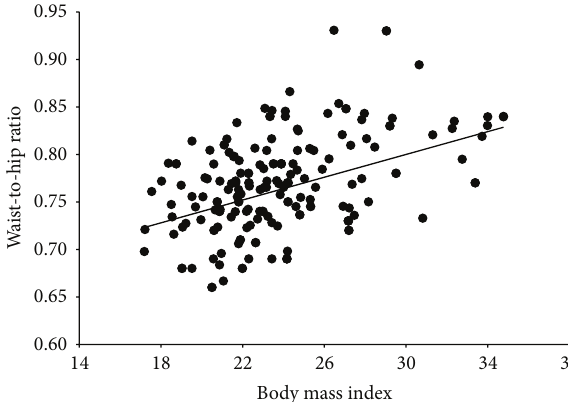
Figure 1: Scatterplot showing the relationship between body mass indexandwaist-to-hipratiooffemaleparticipantsinourstudy.Both variables were significantly correlated ( 𝑃 < 0.0001 ).